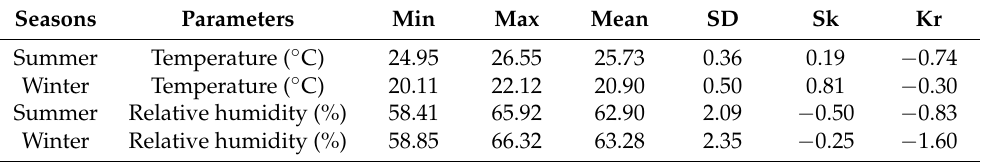
Table 2. Descriptive statistics for the temperature, relative humidity, and